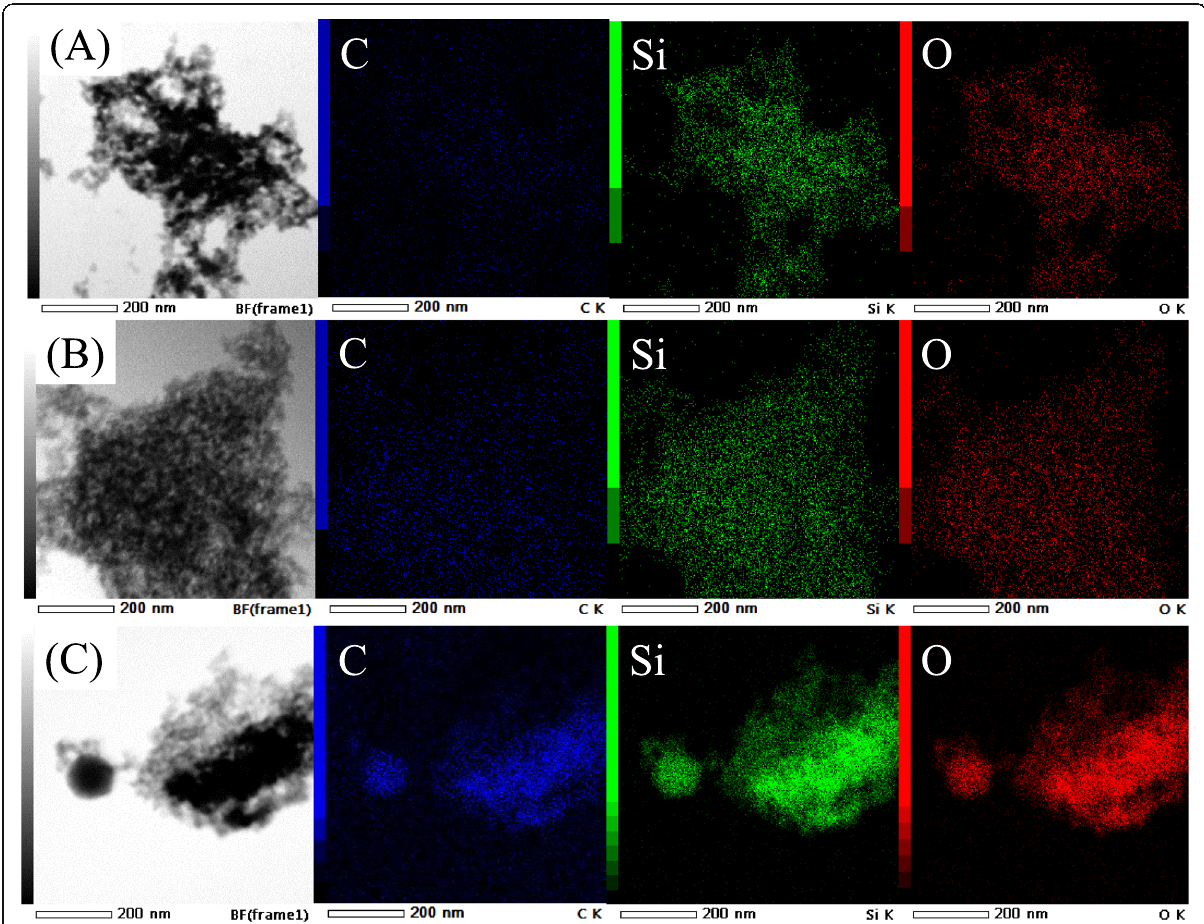
Fig. 6 Representative STEM with EDS mapping images of ( a ) HMS, ( b ) NRHMS, and ( c ) NRHMS(10) at a magnification of